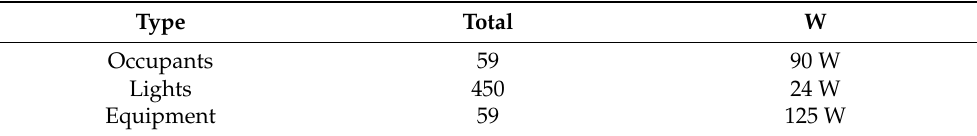
Table 4. Internal gains in